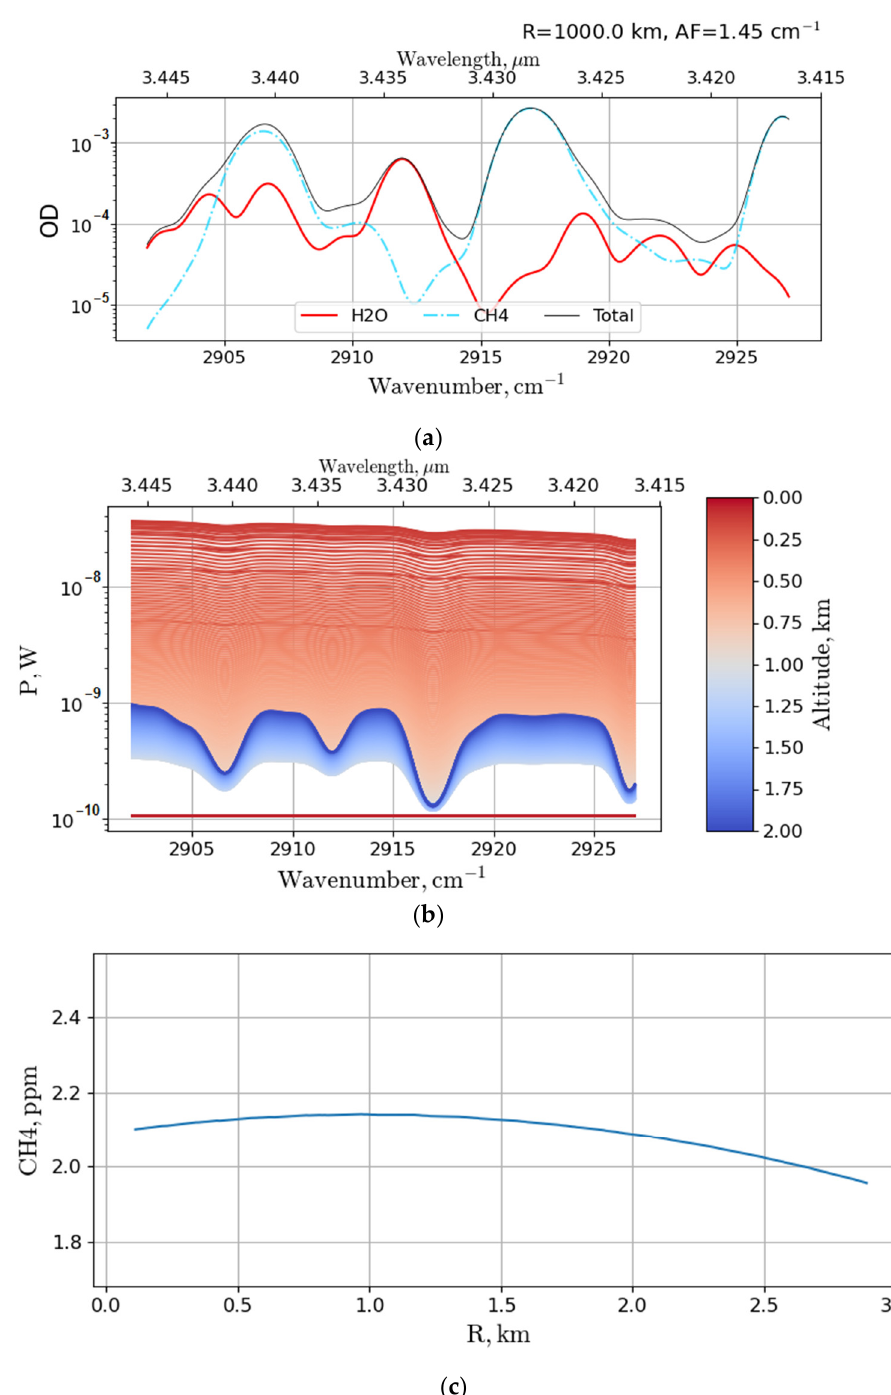
Figure 10. ( a ) Atmospheric optical depth (OD) in the methane sounding informative range; ( b ) li- dar signals (P, W); ( c ) spatial distribution of methane content retrieved from the numerical exper- iment with the atmospheric model of midlatitude summer.